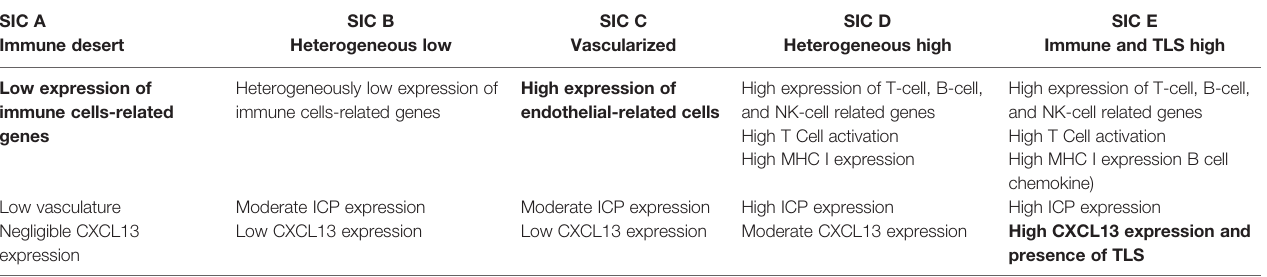
TABLE 2 | Tumor microenvironment features across the different groups in the Sarcoma Immune Classi fi cation (36). SIC